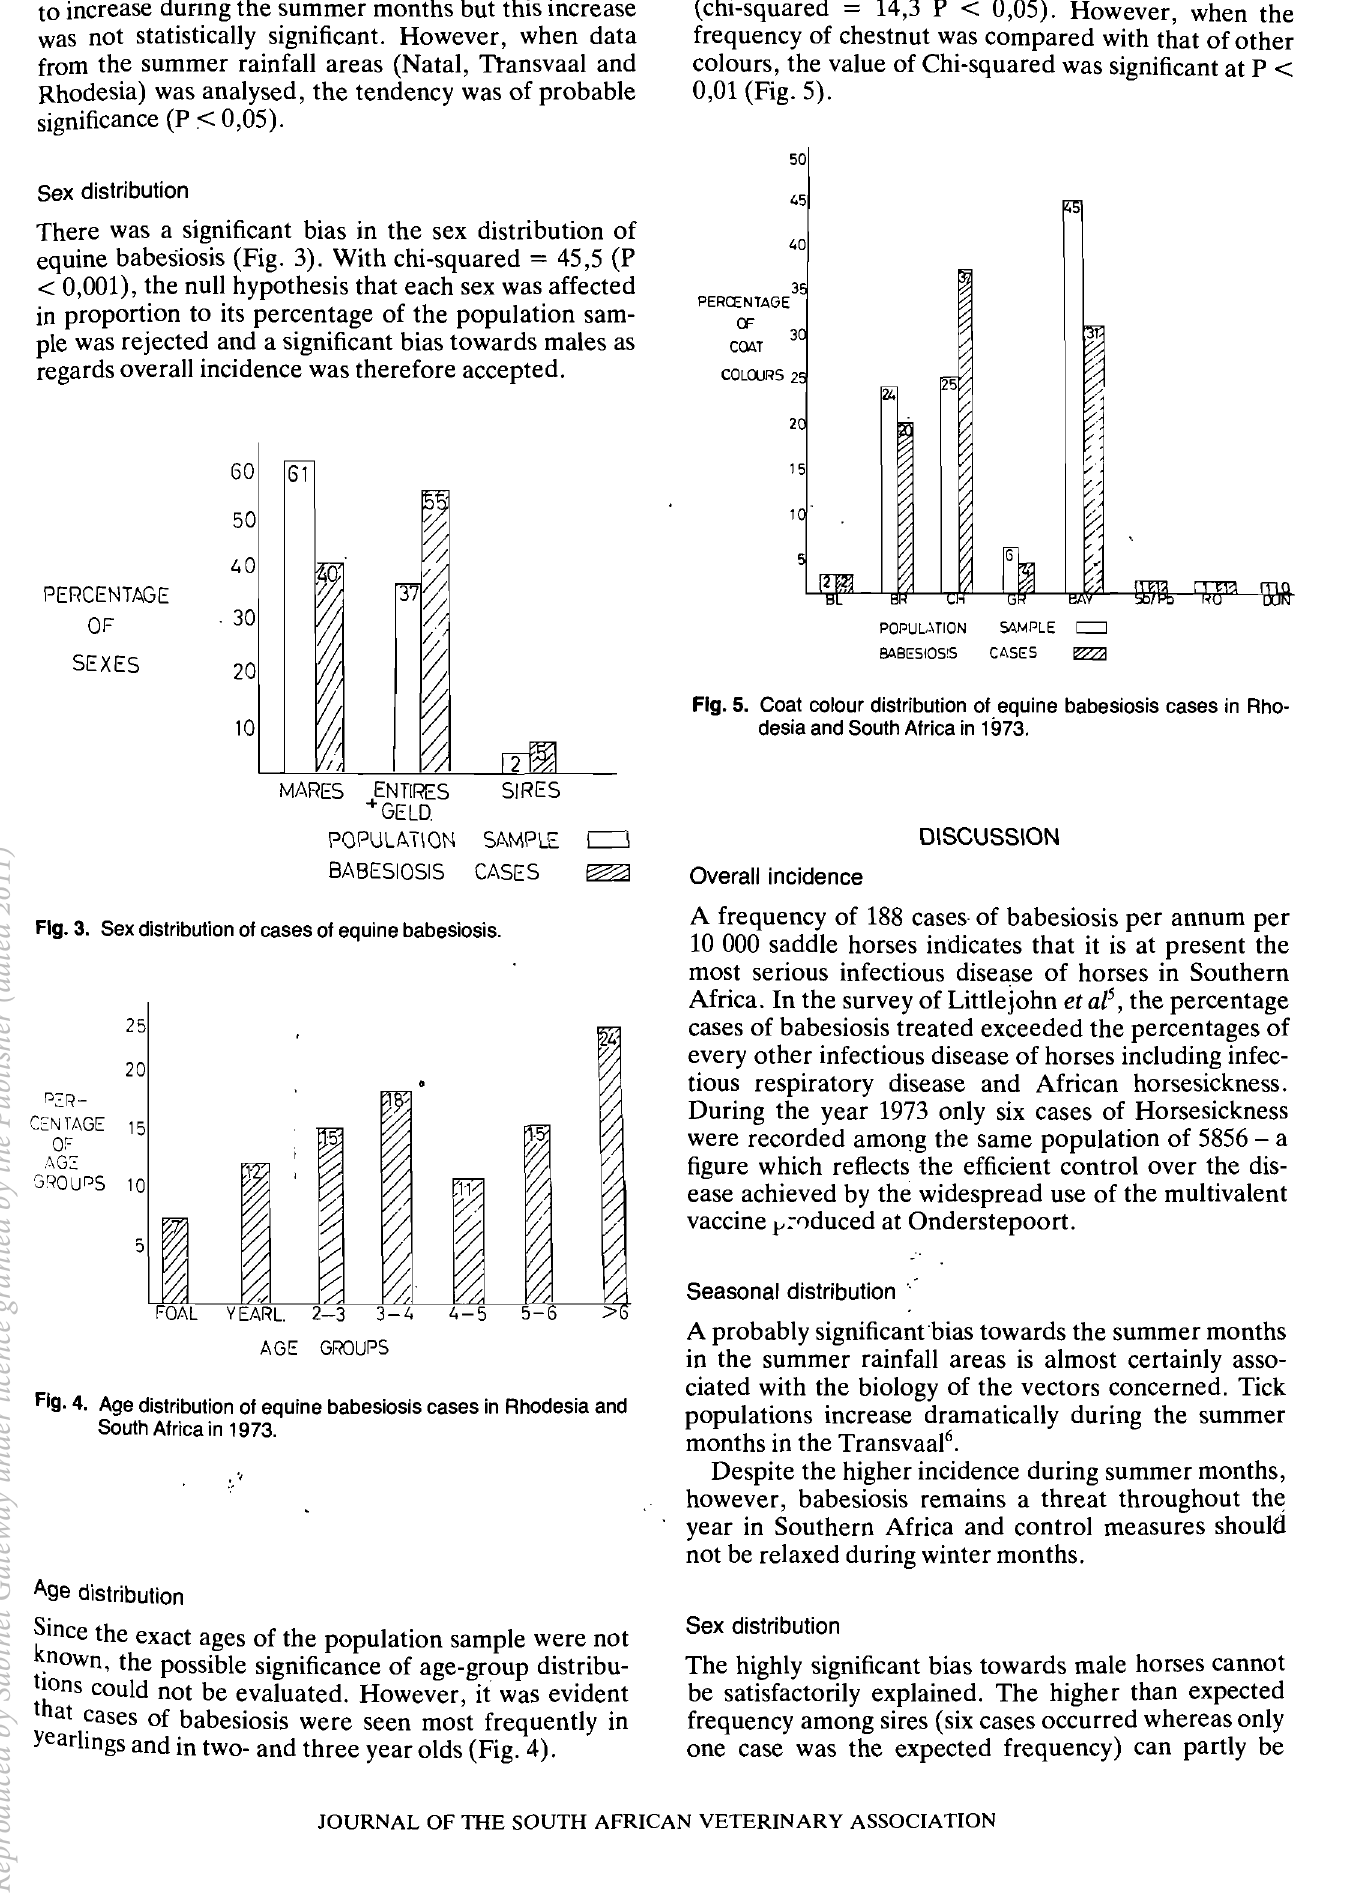
Fig. 4. Age distribution of equine babesiosis cases in Rhodesia and South Africa in 1973.